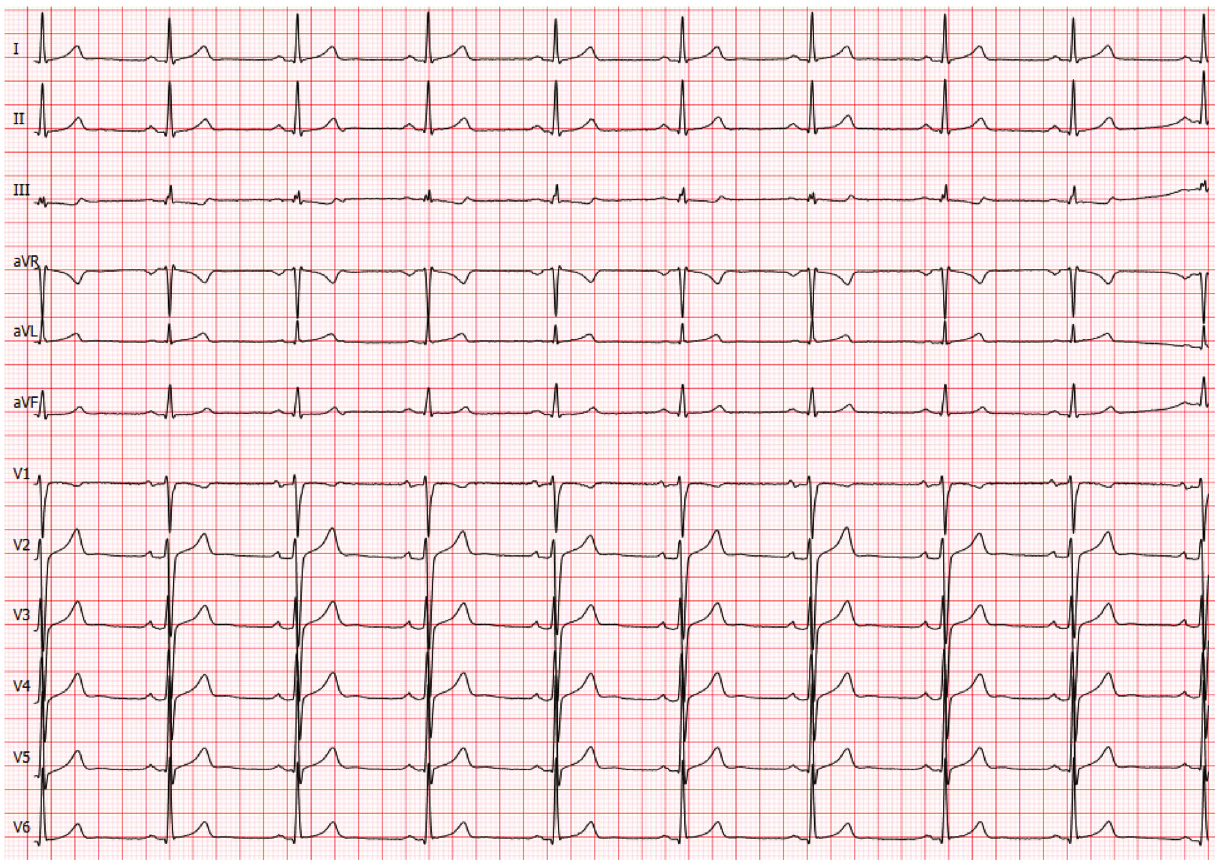
Figure 3: Resting ECG at 1.5-year follow-up. Regular sinus rhythm at a heart rate of 55 beats per minute with persistent signs of left ventricular